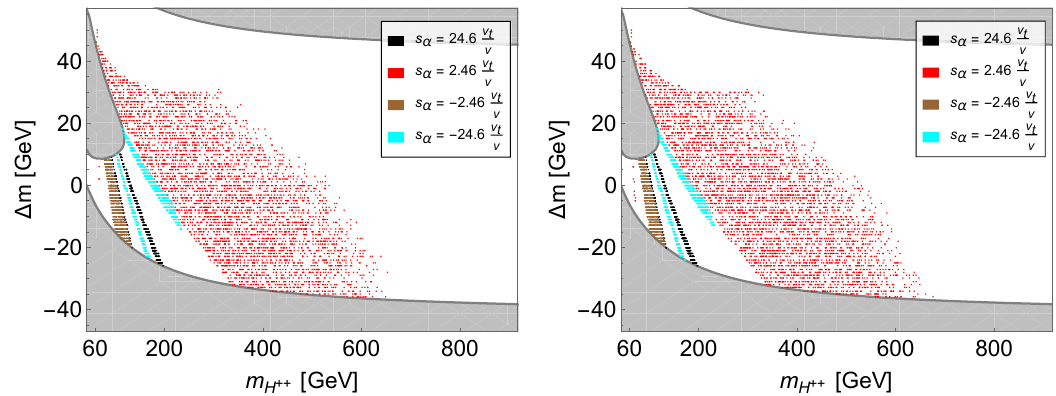
Figure 1 . The region in the m (open) and the 125-GeV Higgs data (scattered) at 95% CL for the case v v t = 10 − 9 GeV (right), with v sin α/v t =